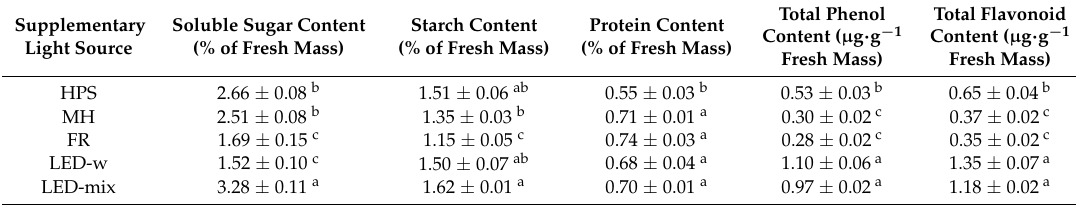
Table 3. The physiological parameters of C. lanceolata seedlings as affected by supplementary light sources. Different alphabets indicate the significant separation within columns by Duncan’s multiple range test at a 0.05